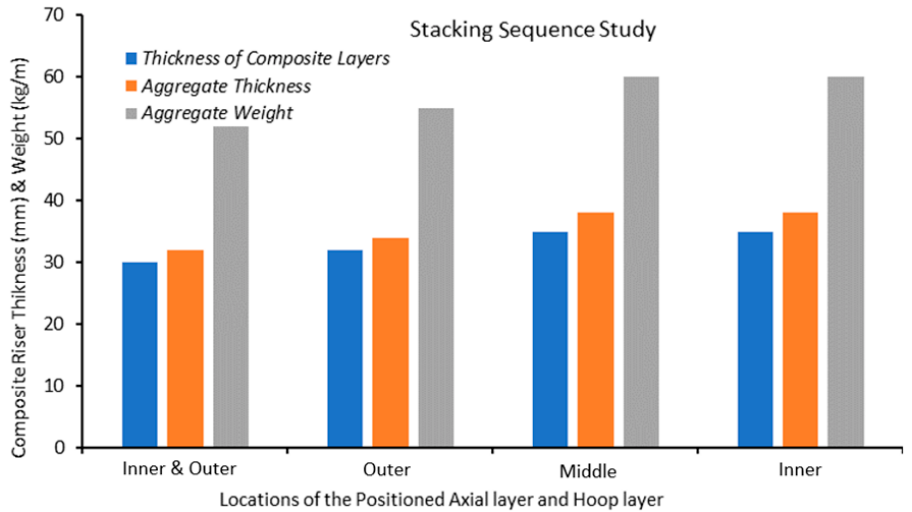
Figure 21. Comparative study at optimized angled plies for normalized structural weights and